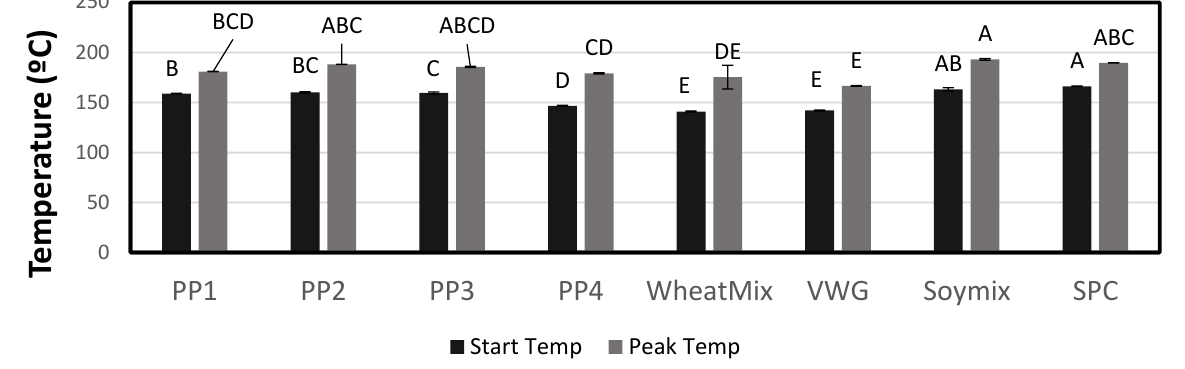
Figure 6. Mean starting and peak temperatures of denaturation for protein in each treatment as determined by DSC. Bars denoted by the same letter are not significantly different ( p < 0.05).